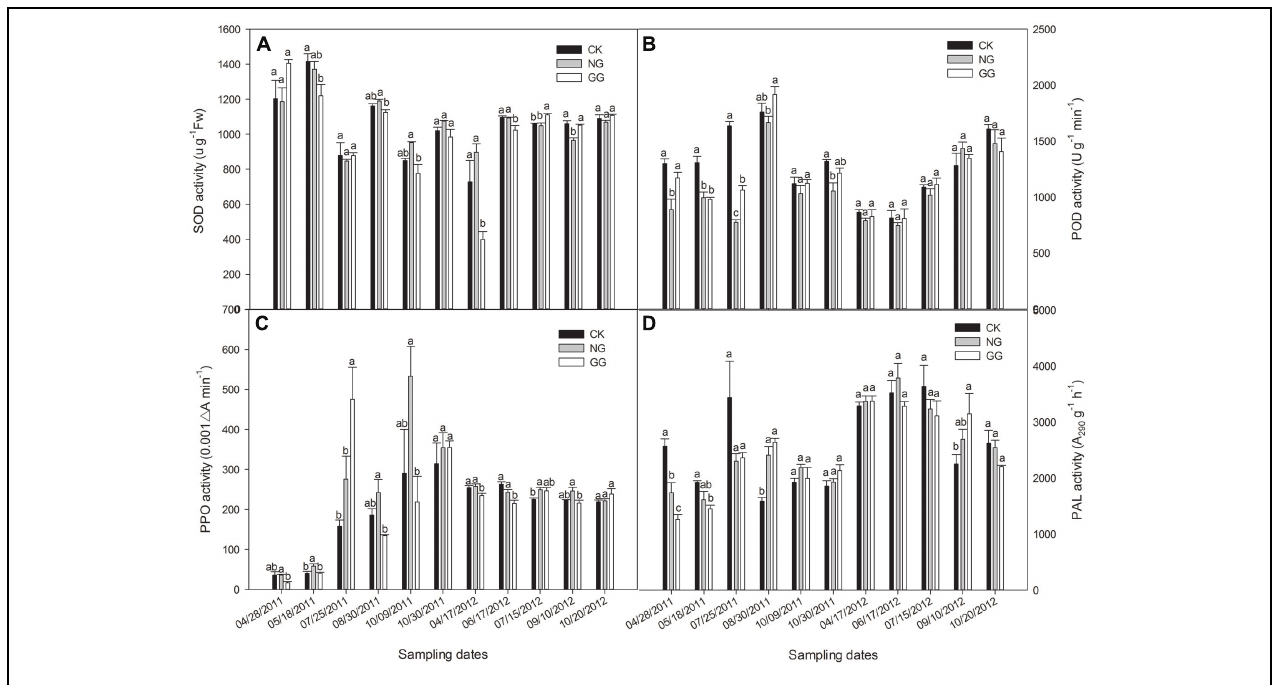
FIGURE 2 | Effects of relay intercropping with normal garlic or green garlic on superoxide dismutase (SOD) (A), peroxidase (POD) (B), polyphenol oxidase (PPO) (C) and phenylalanine ammonia-lyase (PAL) (D) activities in eggplant leaves. Error bars represent the SE of the mean.